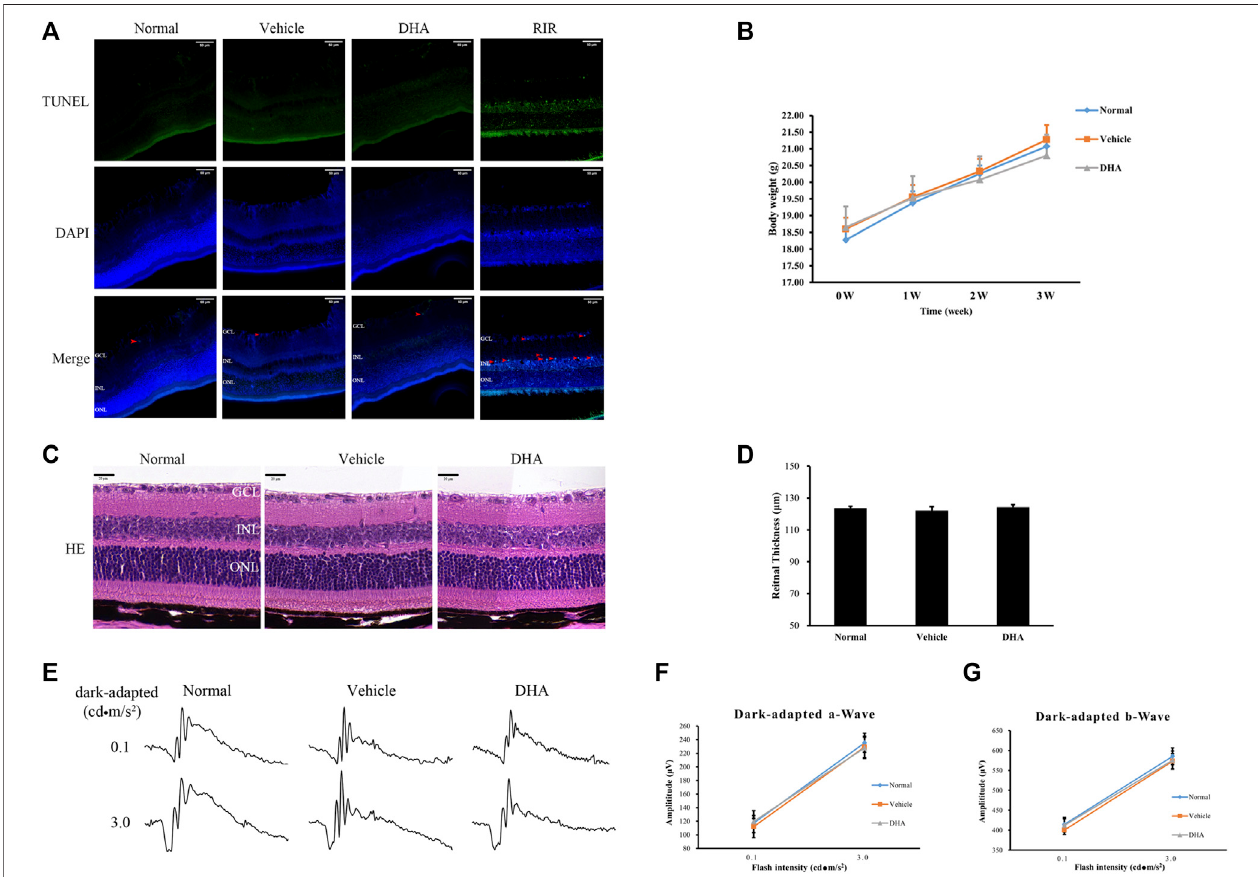
FIGURE 6 | DHA causes no obvious retinal toxicity. (A) DAPI (blue) and TUNEL (green) labeling of retinas obtained from the normal, vehicle, and DHA groups. TUNEL + cells were indicated by red arrowheads. The mouse retina at 24 h after ischemia-reperfusion (IOP raised to 110 mmHg for 1 h) was selected as a positive control group (RIR). Compared to the normal group, there were almost no or very few TUNEL + cells in the mice administered vehicle or DHA, and the retinal cell apoptosiswasunchangedamongthesethreegroups.Scalebar,50 μ m. (B) Changesinbodyweightasamarkerfortoxicity. (C) HEstainingofretinalRPE-choroid complex paraf fi n sections. There were no obvious morphological abnormalities in the vehicle or DHA group compared with the normal group. Scale bar, 20 μ m. (D) Quanti fi cation of the total retinal thickness was shown. (E) Representative ERG responses in the normal, vehicle, and DHA groups. (F) The ERG amplitude versus fl ash intensityfordark-adapteda-wave. (G) TheERGamplitudeversus fl ashintensityfordark-adaptedb-wave.Therewasnosigni fi cantdifferenceamongthesethreegroups. n = 4/group. RIR, Retinal Ischemia-reperfusion; GCL, Ganglion Cell Layer; INL, Inner Nuclear Layer; ONL, Outer Nuclear Layer; HE, Hematoxylin Eosin; DAPI, 4 ′ ,6- diamidino-2-phenylindol; DHA, Dihydroartemisinin; TUNEL, TdT-mediated dUTP nick-end labeling; IOP, Intraocular Pressure.